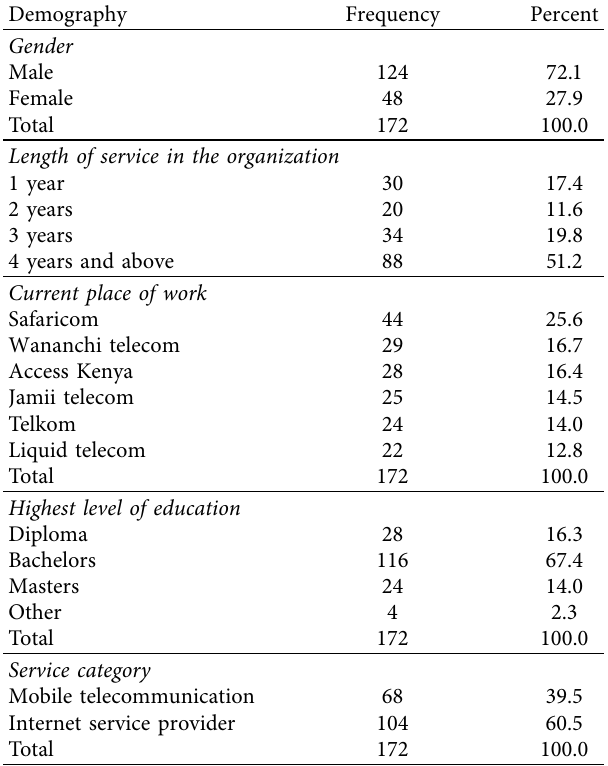
Table 1: Demographic